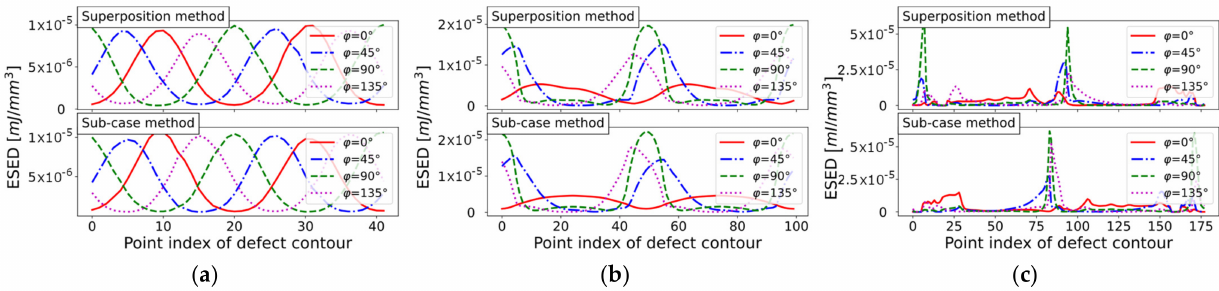
Figure 28. ESED course for three defect geometries evaluated as blunt notch and with incremental load step of ∆ ϕ = 10 ◦ : ( a ) Circular hole-in-plate (mesh ‘circle_lin_R1mm_v1’); ( b ) Elliptical hole-in- plate (mesh ‘ellipsis_lin_rot0deg_v1’); and ( c ) Elongated defect (mesh